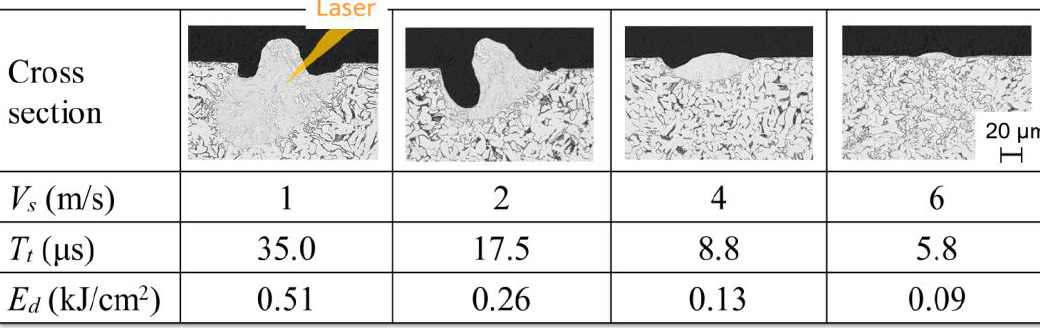
Figure 4. Cross sections of micro-grooves obtained at various scanning speeds ( P = 200 W, incident angle ( θ i ) = 45°, d s = 35 μm, and power density ( P d ) = 14.7 MW/cm 2 , mild steel).